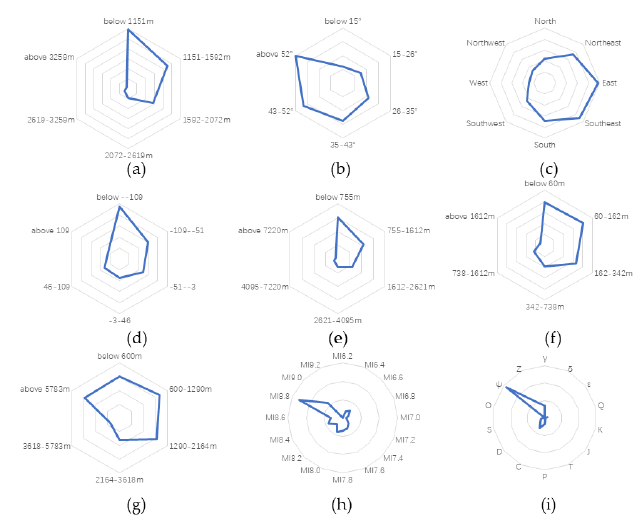
Figure 12. Relative distribution of different influencing factors and post ‐ earthquake landslide occurrence with ( a ) DEM; ( b ) slope; ( c ) aspect; ( d ) mTPI; ( e ) distance from fault; ( f ) distance from road; ( g ) distance from stream; ( h ) MI; and ( i ) lithology.